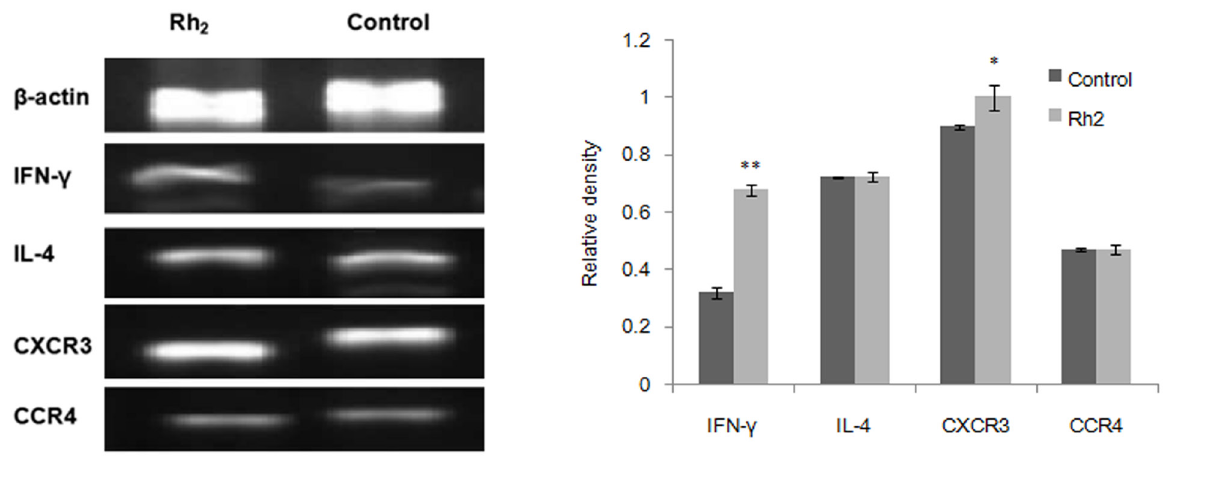
on mRNA expression for Th1/Th2 cytokines and chemokine receptors in T lymph node cells. Bands were Figure 2: Effects of ginsenoside Rh 2 quantified by densitometric analysis relative to β-actin. (Mean ± SD, N=3), * P<0.05 vs. control; ** P<0.01 vs.